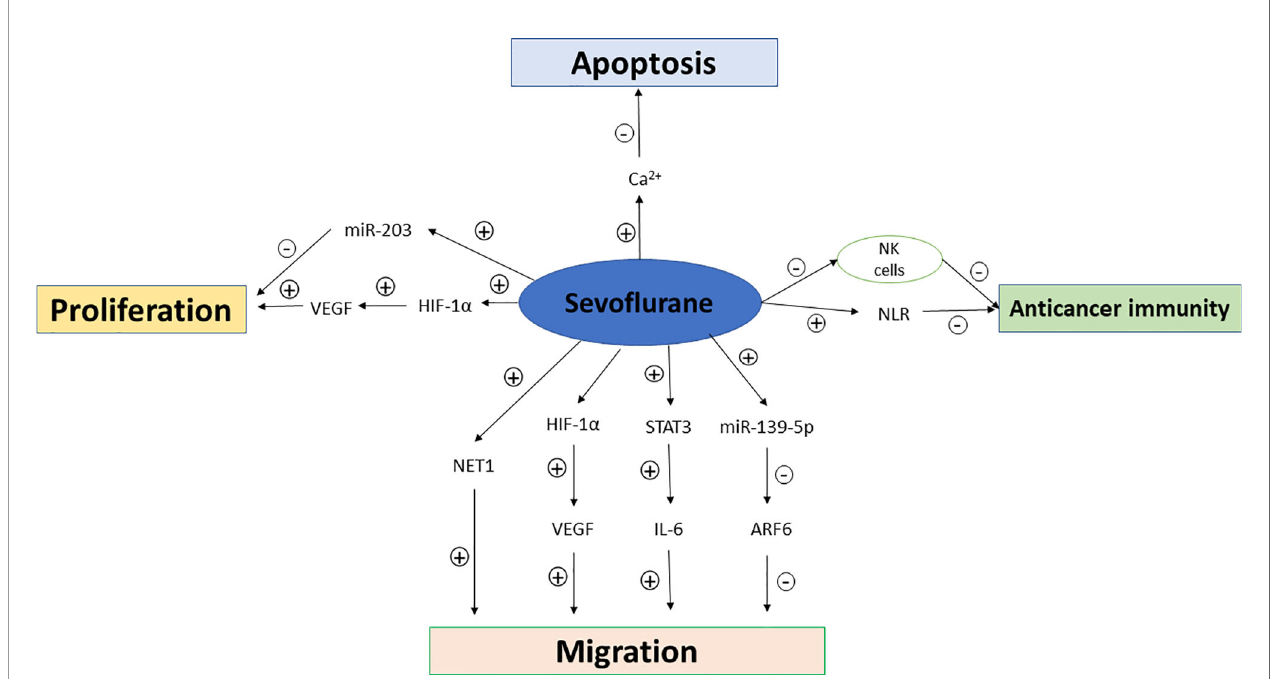
FIGURE 2 | Mechanisms of sevo fl urane on anticancer immunity, breast cancer cell proliferation, migration and apoptosis. NK cells, natural killer cells; NLR, neutrophil – lymphocyte ratio; VEGF, vascular endothelial growth factor; HIF-1 a , hypoxia inducible factor-1 a ; NET1, Neuroepithelial Cell Transforming Gene; STAT3, signal transducer and activator of transcription 3; ARF6, ADP-ribosylation factor